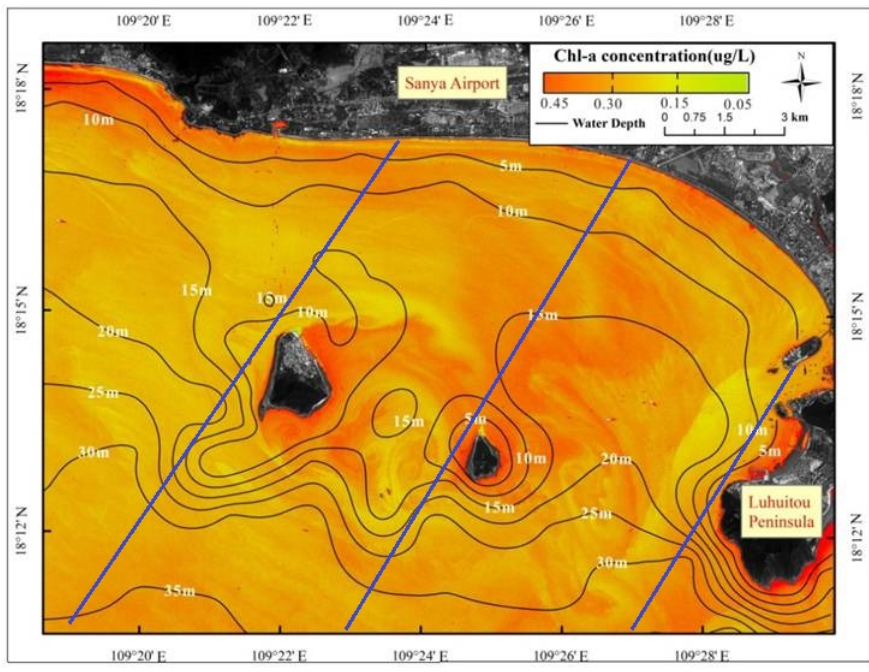
Figure 21. The difference between the concentration of Chl-a results retrived by r rs and by a phy (490).